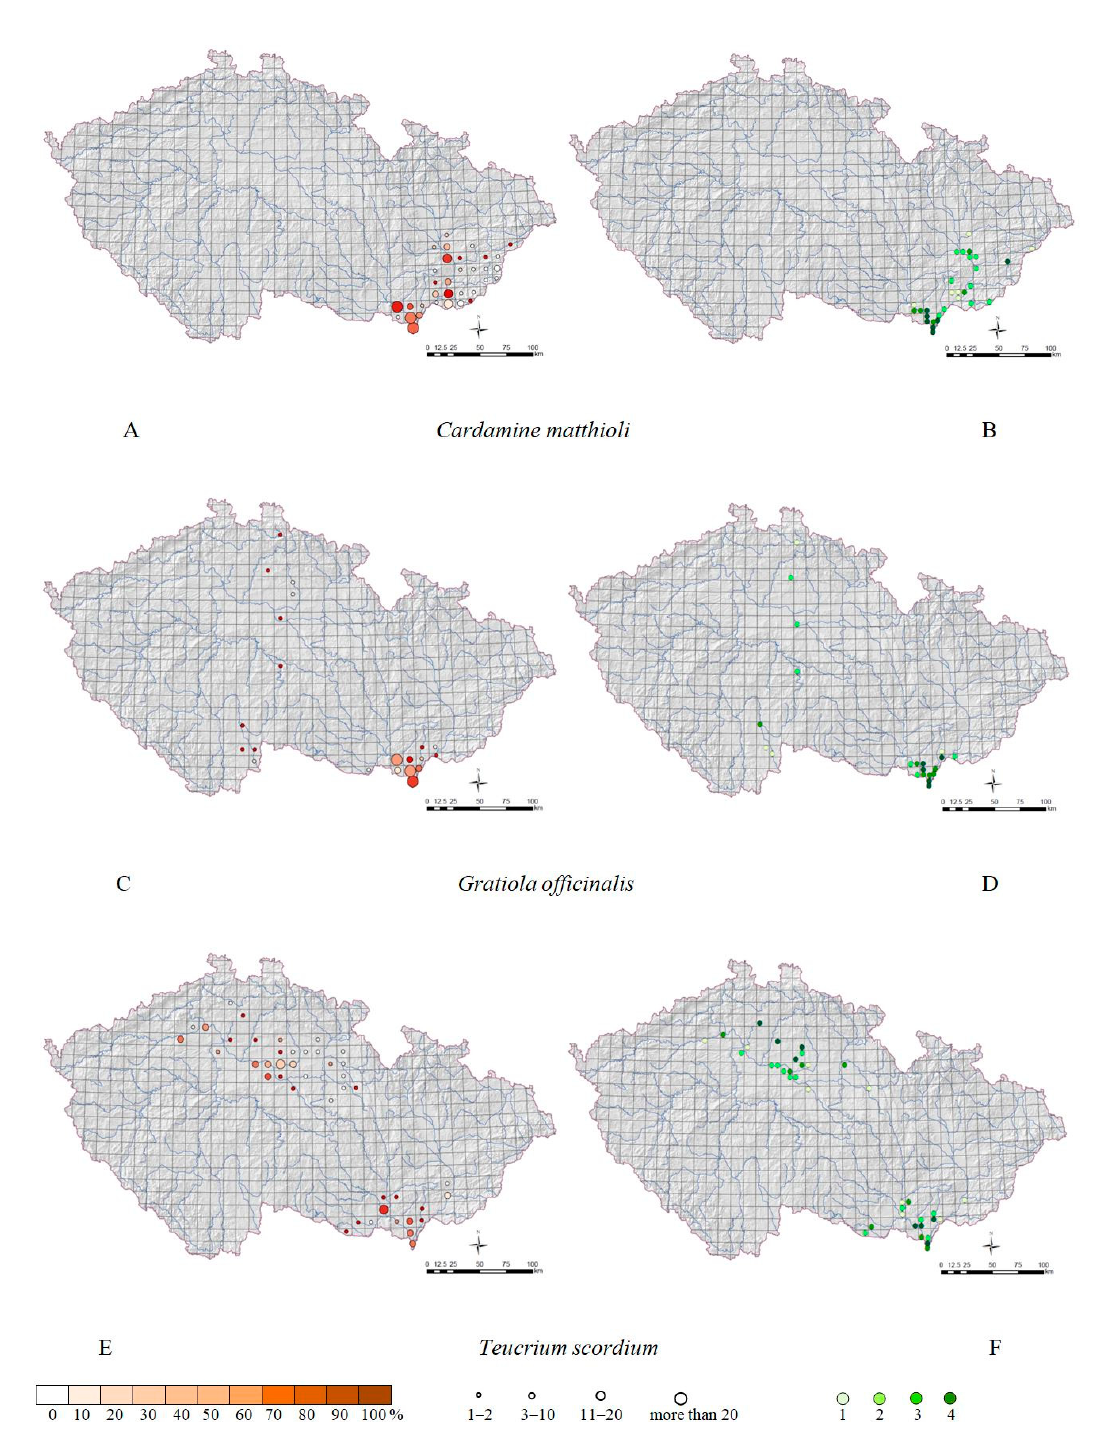
Figure 2. Maps ( A , C , E ): number of occurrences (dot size) and knowledge level of habitat quality (brownish colour); empty circle (0 %) = occurrence of the species outside the habitat. Maps ( B , D , F ): habitat quality (1–4); the darker the green colour, the lower the values of quality are. Grid of 10 × 10